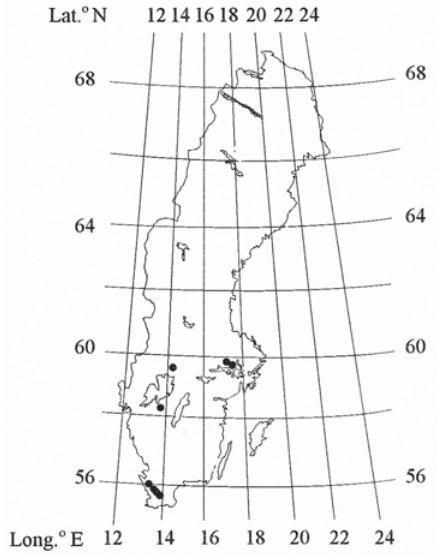
Figure 1. Locations of the study sites, all of which were located on abandoned farmland in Sweden.